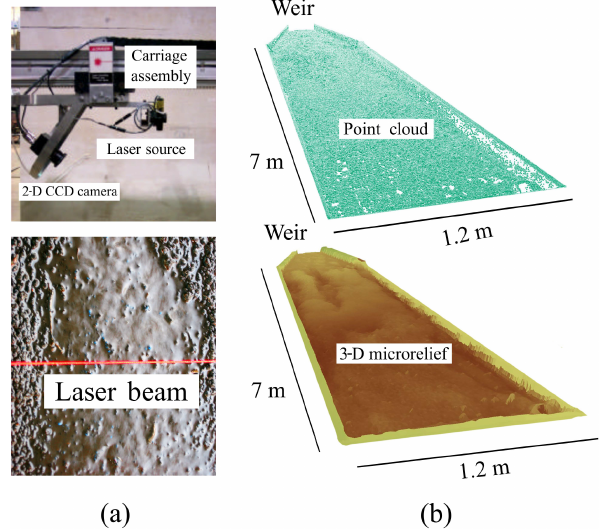
Figure 4. (a) Instantaneous digital surface-profile laser scanner used in the experimental runs and laser beam projected on the soil surface. (b) Cloud of ( x , y , z ) data acquired from the laser scan- ner for an experimental test along with the associated 3-D repre- sentation of the soil surface microrelief through inverse distance weighted